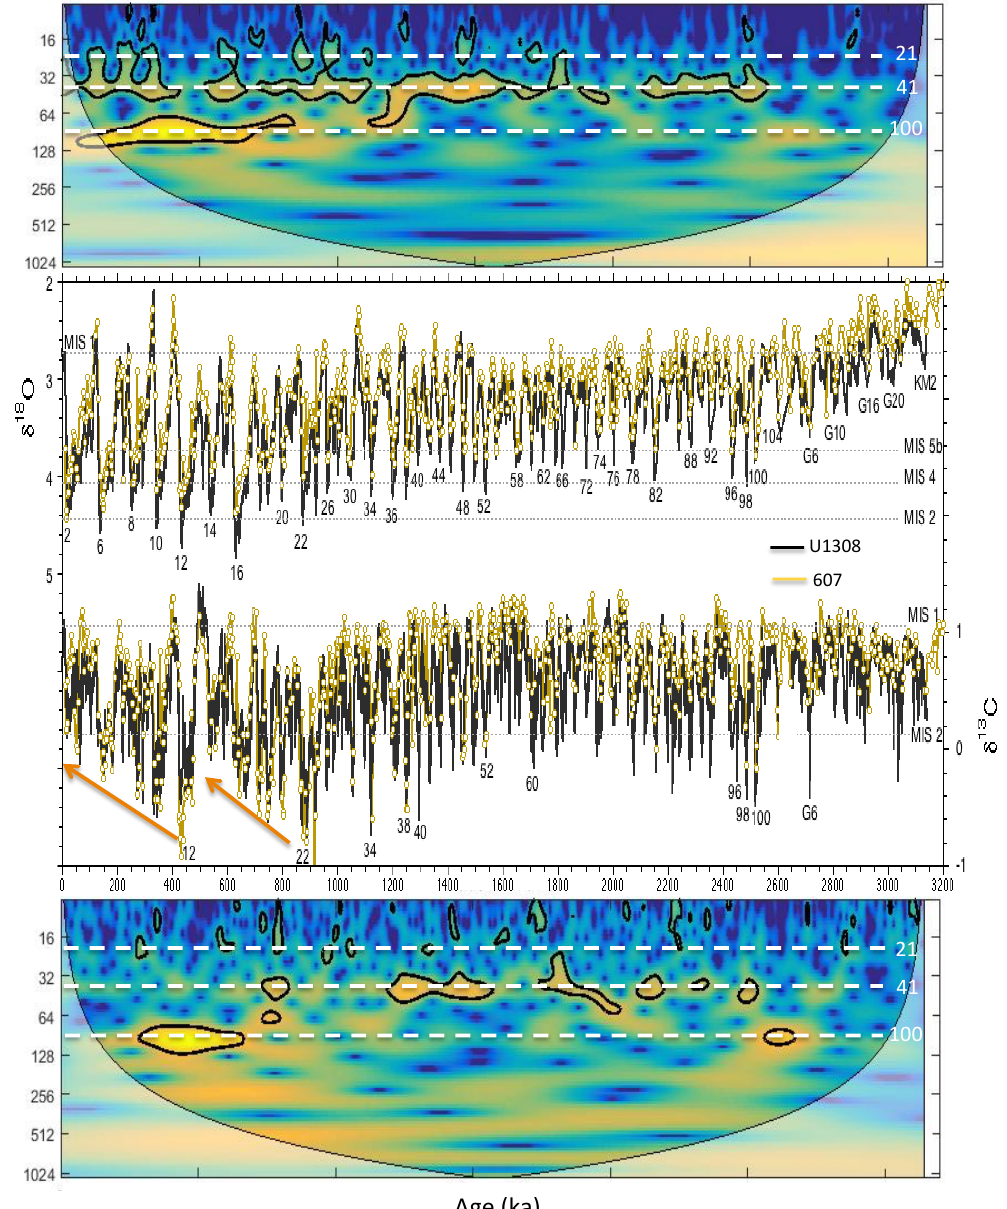
Figure 3. Benthic oxygen and carbon isotope records for IODP Site U1308 (black) and DSDP Site 607 (gold; Ruddiman et al., 1986; Raymo et al., 1986). Prominent marine isotope stages are labeled and δ 18 O values corresponding to MIS 5b, 4, and 2 are marked for reference. The orange arrows on the benthic δ 13 C record highlight two trends of decreasing glacial δ 13 C from MIS 22 to 14 and again from MIS 12 to 2 originally described by Raymo et al.